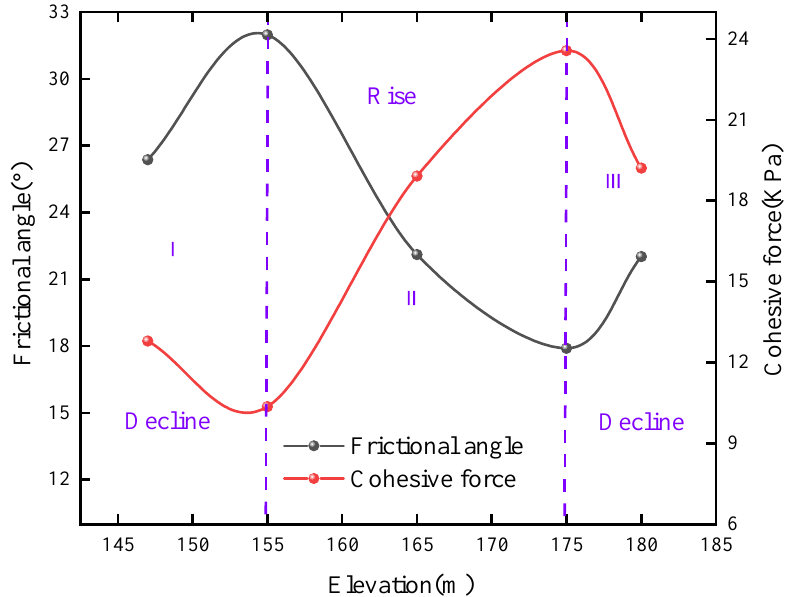
Figure 6. Cohesion and friction